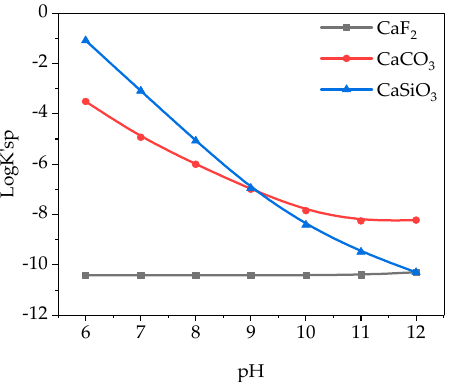
Figure 5. Effect of pH on the conditional solubility products of CaF 2 , CaCO 3 , and CaSiO 3.